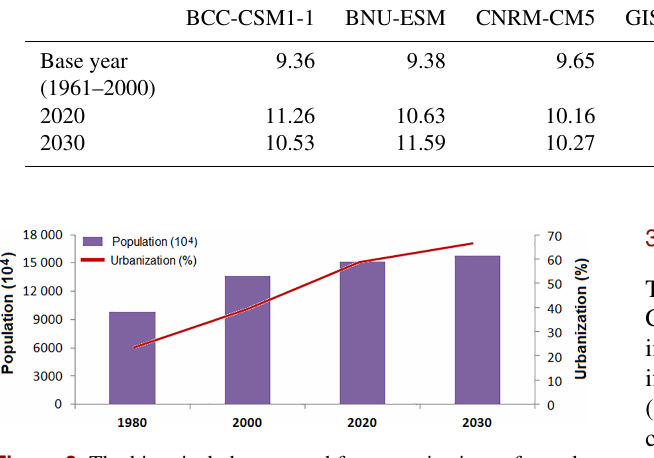
Figure 2. The historical changes and future projections of popula- tion and urbanization in the Haihe River